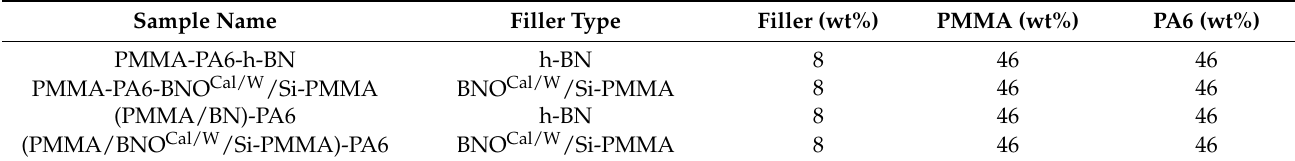
Table 5. Samples